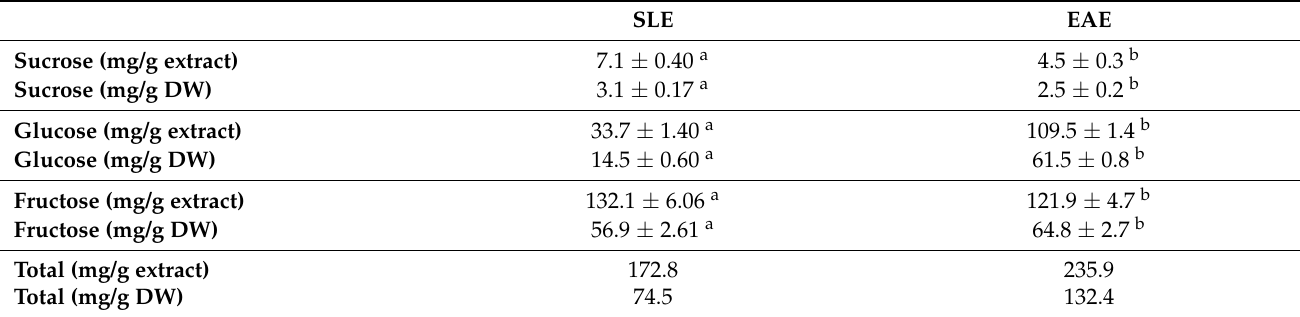
Table 3. Mono- and disaccharide content of the water-soluble fractions of bilberry pomace obtained using SLE and EAE. SLE EAE Sucrose (mg/g extract)